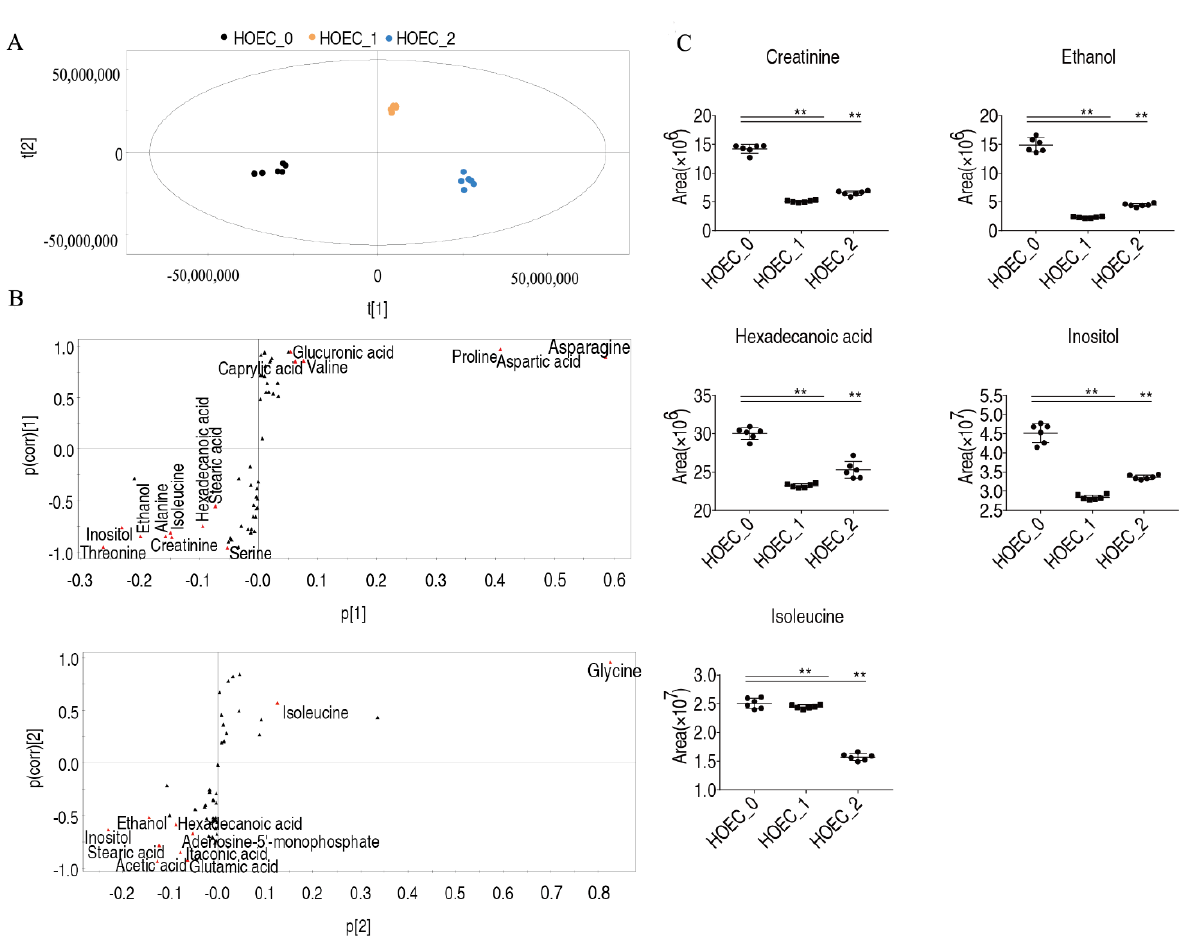
Figure 8. Screening of metabolic biomarkers in response to cisplatin exposure in HOEC cells. OPLS- DA analysis ( A ). S-plot analysis ( B ). Relative abundance of biomarkers ( C ). HOEC_0, HOEC_1 and HOEC_2 represent the HOEC cells treated with cisplatin for 0 h, 24 h or 48 h. **, p < 0.01.